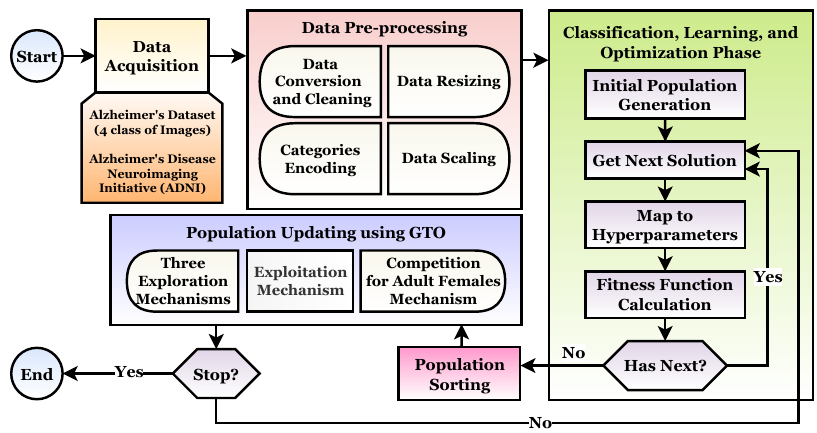
Figure 5. The suggested A 3 C-TL-GTO